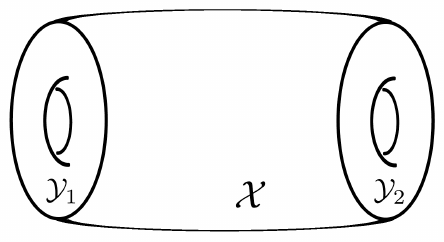
Figure 23: Two-dimensional compact manifolds Y manifold X .